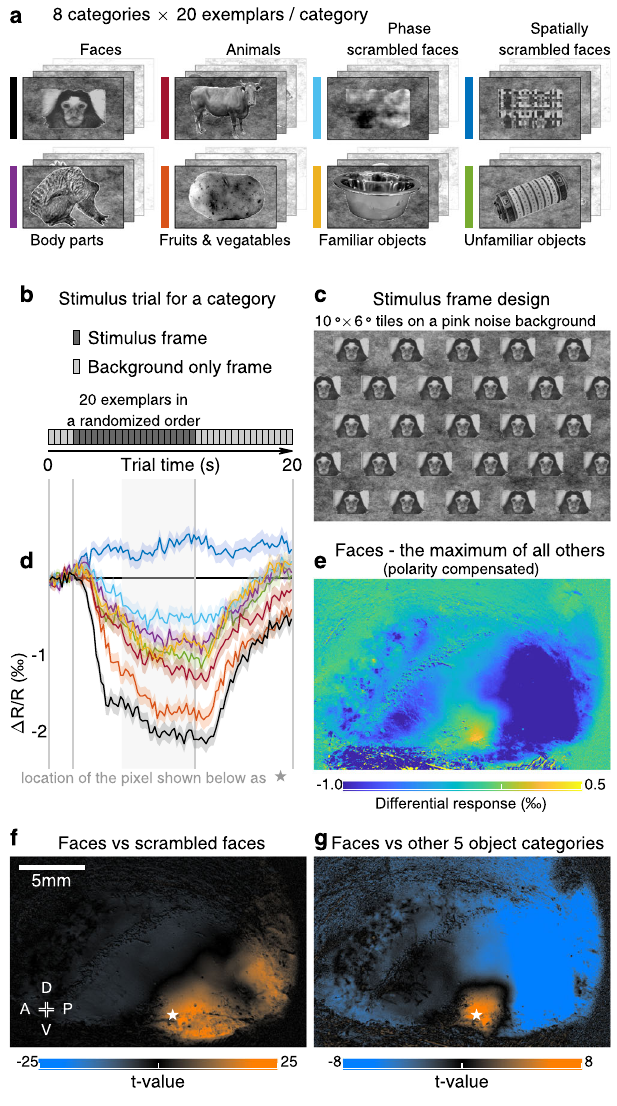
and Supplementary Fig. 7: faces, body parts, animals, fruits & vegetables, familiar objects, unfamiliar objects, spatially scrambled faces, and phase-scrambled faces). A clear patch located at the ventral part of the motion-sensitive region showed a stronger response to faces than to any other control categories (Fig. 6d – g).